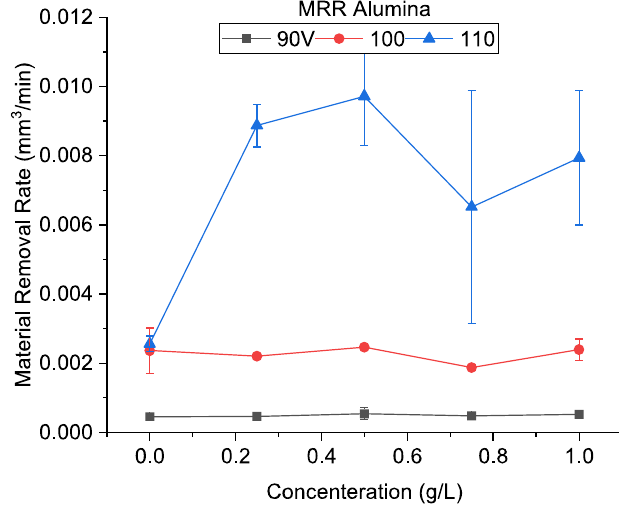
Figure 15. Material removal rate using alumina-mixed